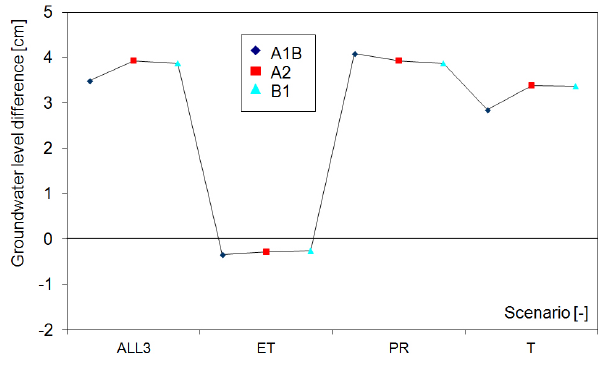
Fig. 13. Mean level of impact results on groundwater (average over the simulation; period 2000 ∼ 2001 and averaged over the entire Kaidu river basin; after the MIKE-SHE simulation (after changes to all or individual hydro-climatic